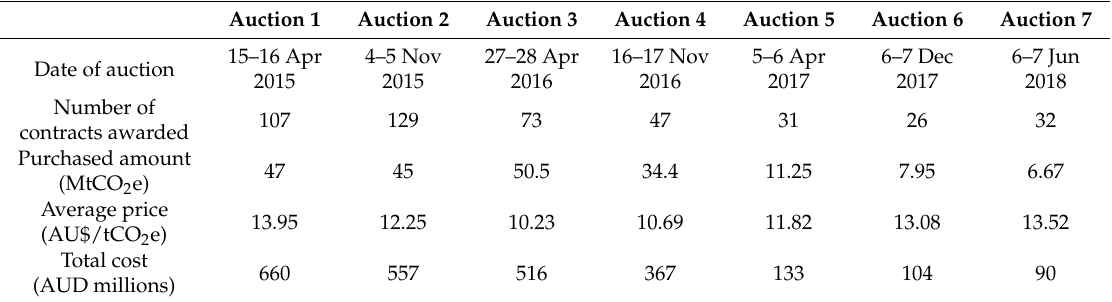
Table 1. Key statistics of seven reverse auctions held under Australia’s Emission Reduction Fund (2015–2018); dollars are AUD (adopted from